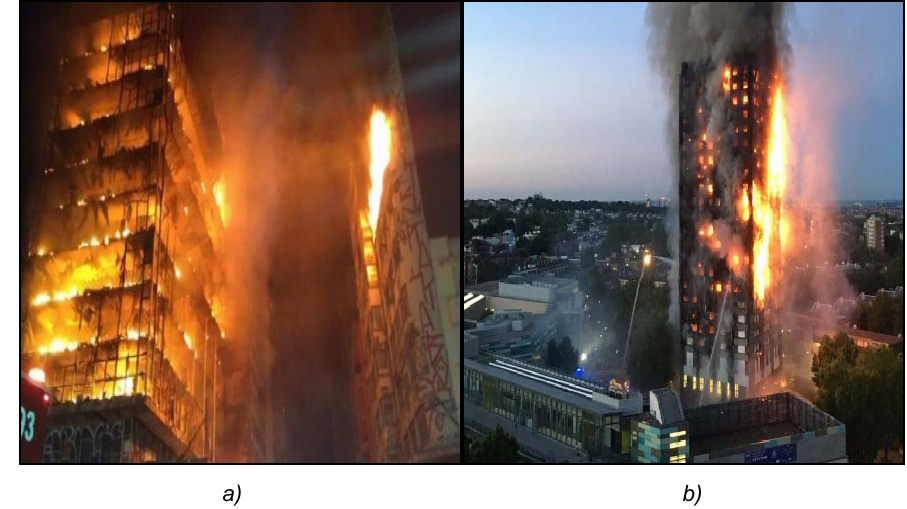
Figure 1 – Huge fire in a residential building in Sao Paolo, Brazil, in 2018 (a) (Fos Media, 2018) and a huge fire in the residential building Grenfell Tower in London, UK, in 2017 (b) (Hartley-Parkinson, 2019) Parkinson,